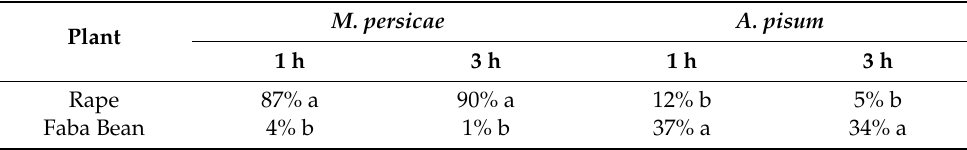
Table 1. Percentage of Myzus persicae and Acyrthosiphon pisum that settled on rape and faba bean. Plant